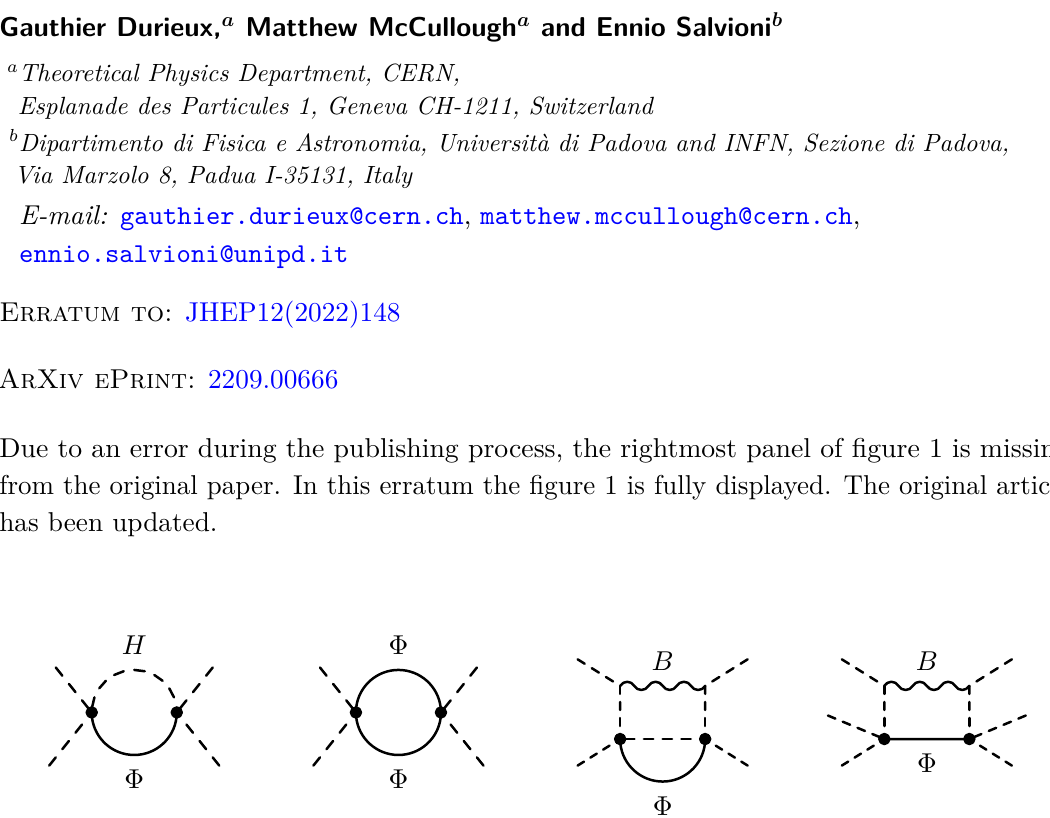
Figure 1 . Illustrative diagrams involved in the loop-level matching of the weak quadruplet models to Higgs operators violating custodial symmetry at dimension-6 and